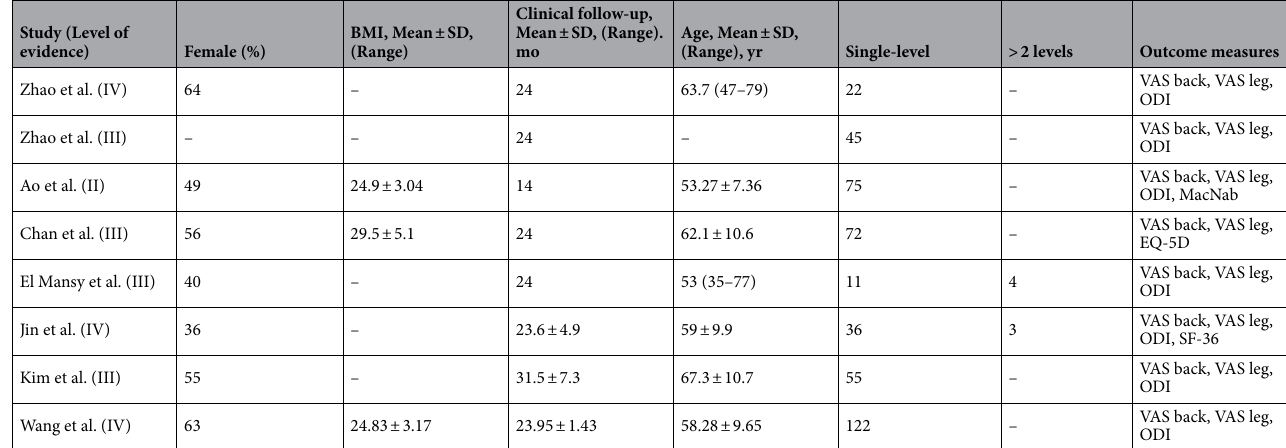
Table 1. Characteristics of included studies. DDD degenerative disk disease, DSP degenerative spondylolisthesis, ISP isthmic spondylolisthesis, DST degenerative spinal stenosis, DSC degenerative spinal scoliosis, VAS Visual Analogue Scale, ODI Oswestry Disability Index, NSS Neurogenic Symptom Score, SF-36 short form 36, NASS North American Spine Society scores for neurogenic symptoms, JOA Japanese Orthopaedic Association scores, EQ-5D Euro-Qol-5 dimension